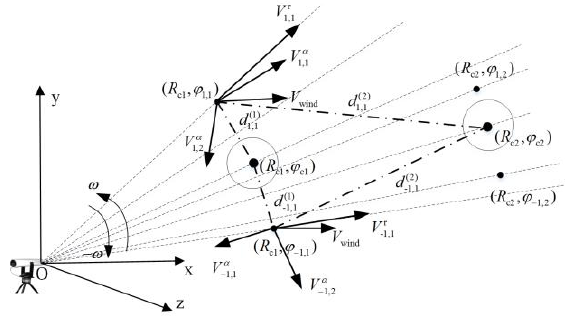
Fig. 2 Velocity Component of The Detection